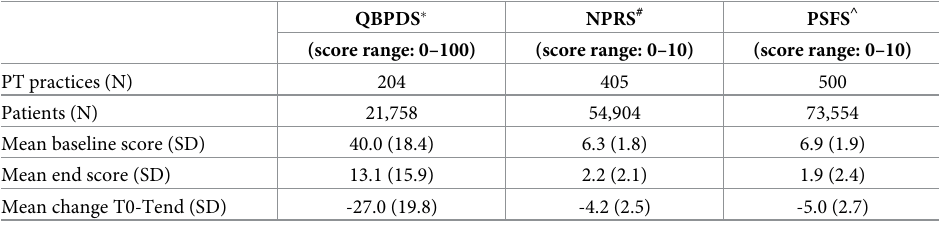
Table 1. Descriptive statistics of mean PROM-scores (unadjusted for T0 scores) at practice